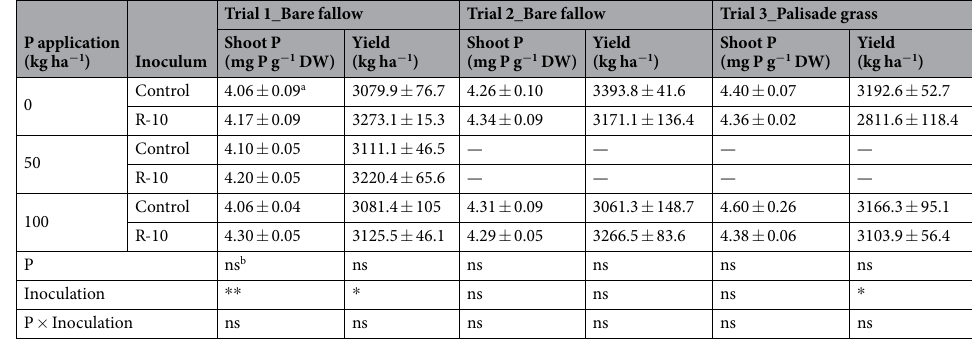
Table 1. Effect of AM fungal inoculation and phosphorus (P) fertilizer application on shoot P concentration of the flowering stage and grain yield of Glycine max in the three trials. a ± SE ( n = 4). b ANOVA: ns, not significant; * P < 0.05; ** P <